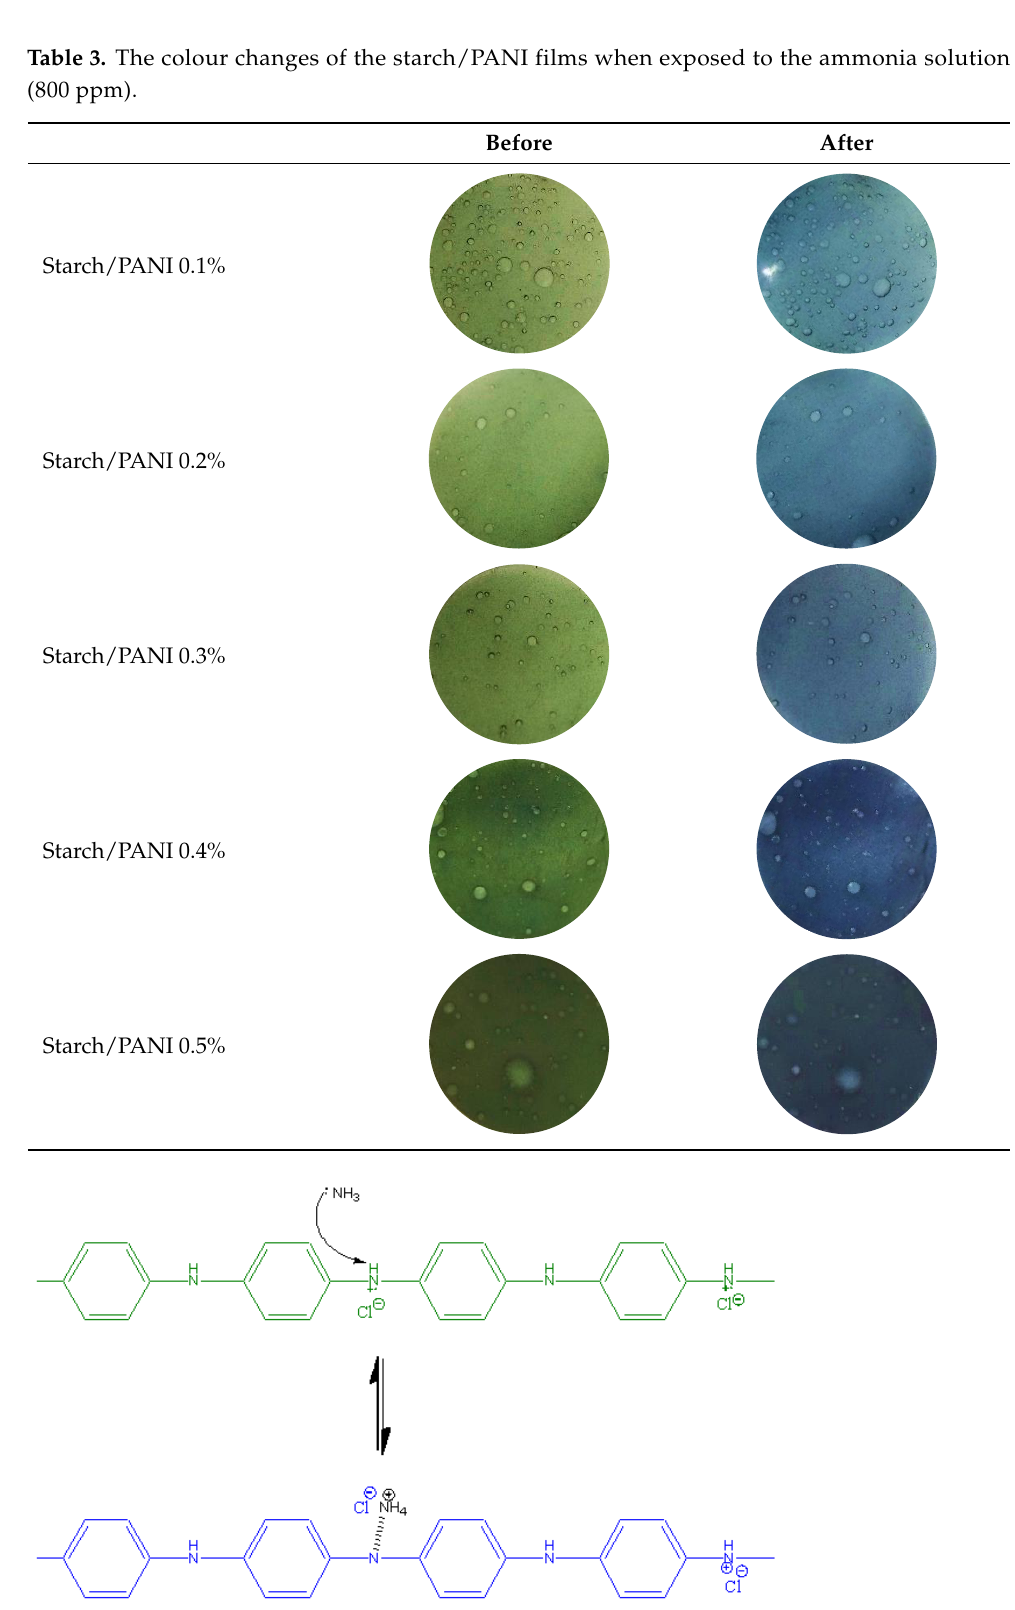
Table 3. The colour changes of the starch/PANI films when exposed to the ammonia solution (800 ppm). Before After